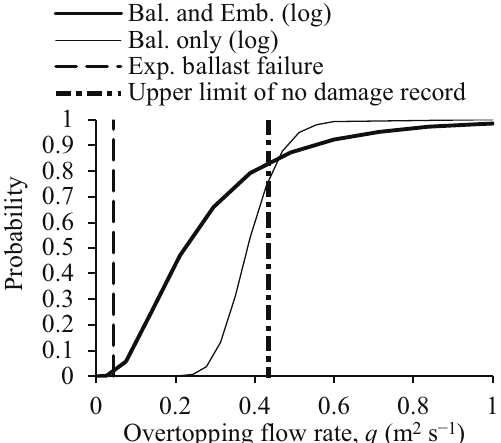
Figure 13. Fragility curve for ballast failure using overtopping flow rate per unit length. The dashed line indicates the experimental bound at which the onset of ballast scour occurs (Tsubaki et al., 2012b). The double line corresponds to the upper limit of the flow condition where no damage was